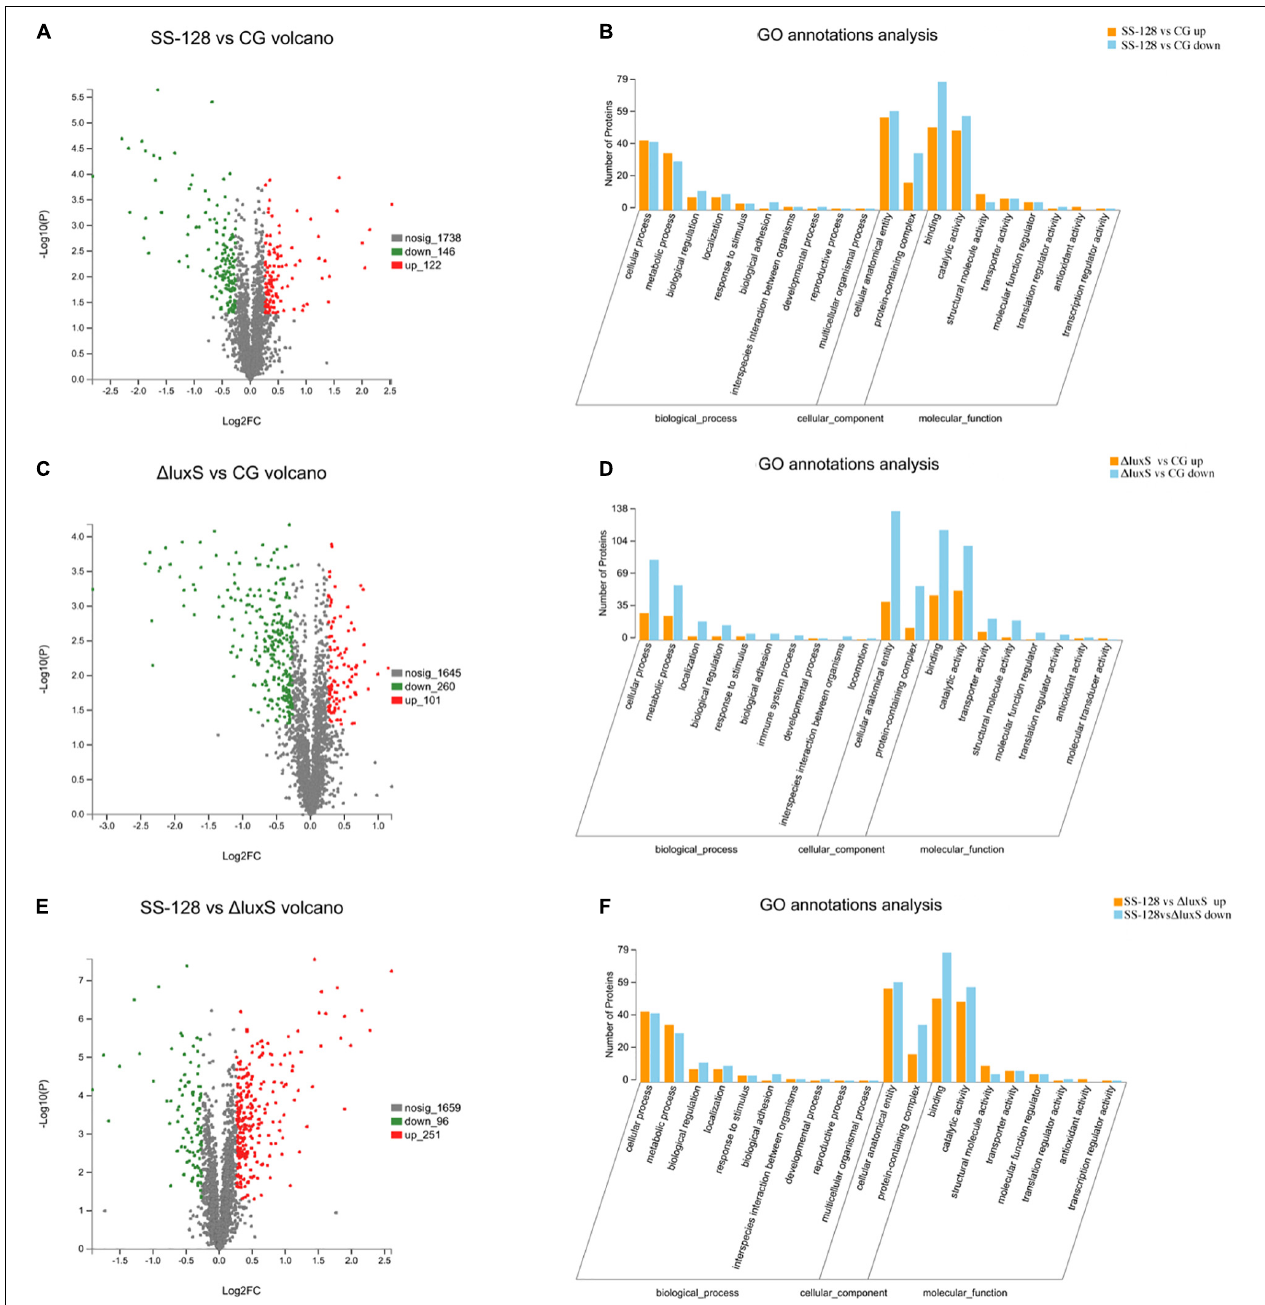
FIGURE 5 | Classifications of differential proteins in Litopenaeus vannamei . (A) SS-128 vs. CG volcano; (B) SS-128 vs. CG GO annotation analysis; (C) (cid:49) luxS vs. CG volcano; (D) (cid:49) luxS vs. CG GO annotation analysis; (E) SS-128 vs. (cid:49) luxS volcano; (F) SS-128 vs. (cid:49) luxS GO annotation